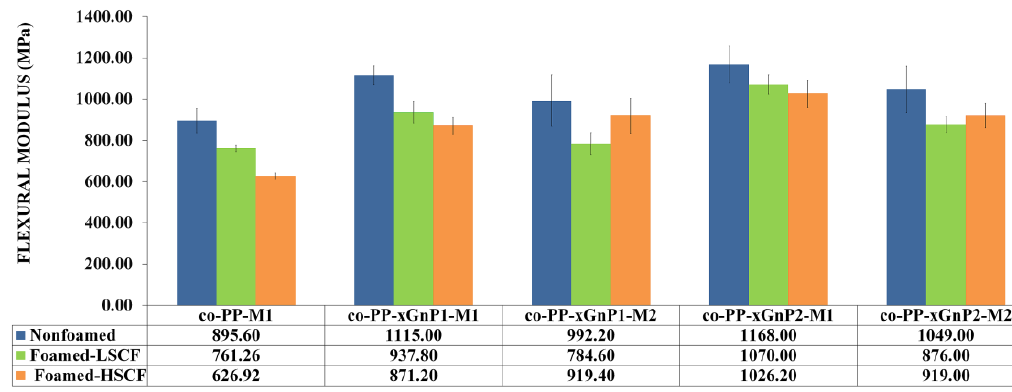
Figure 6. Flexural modulus of samples.